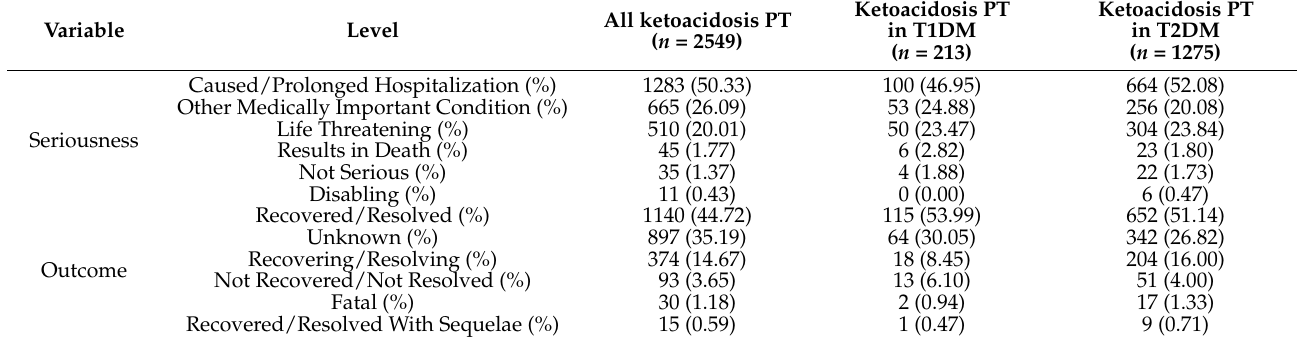
Table 2. Seriousness and outcome of ketoacidosis adverse events distributed by type of diabetes and having dapagliflozin as suspected drug among those reported in Eudravigilance from the date of marketing authorization to 11 September